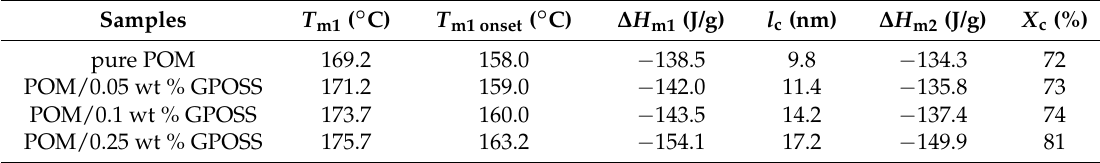
Table 1. DSC data of pure POM and POM/GPOSS composites (cooling and heating rate: 20°/min).